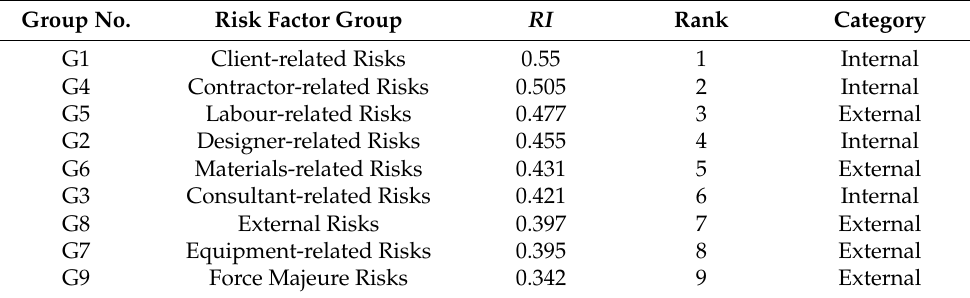
Table 4. The most important group of risk